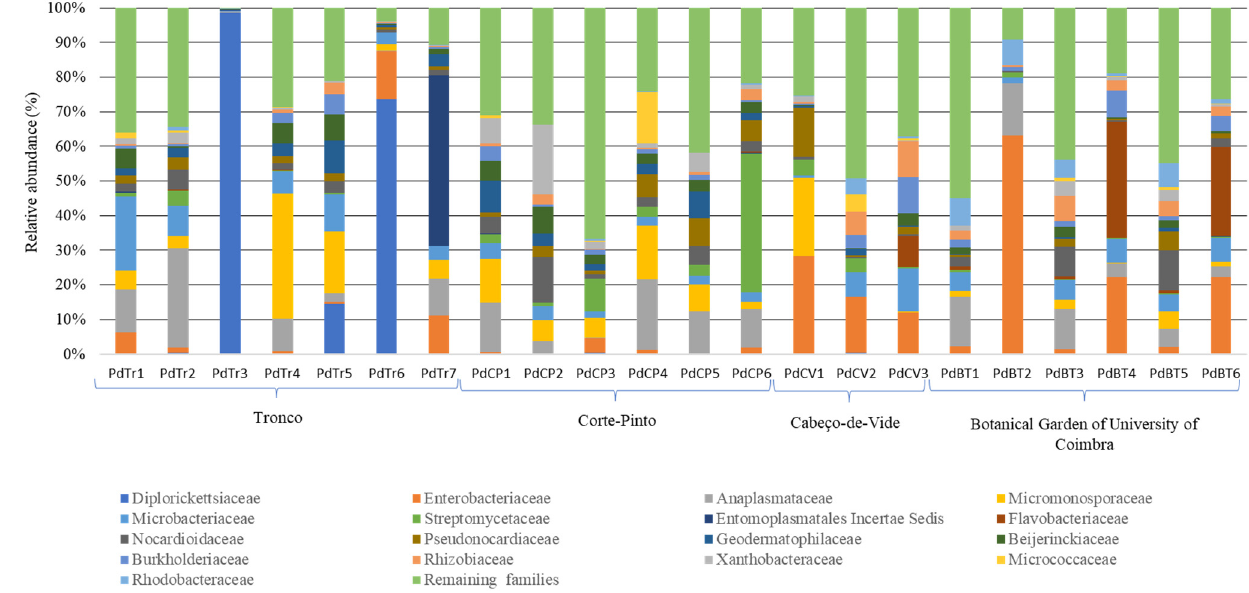
Figure 2. Composition of Porcellio dilatatus gut bacterial communities, at the family level. Isopods were collected from Tronco (PdTr); Corte-Pinto (PdCP); Cabeço-de-Vide (PdCV) and Botanical Garden of University of Coimbra (PdBT) in this study. Only the seventeen most abundant families were represented. The other families were assigned as the remaining families.